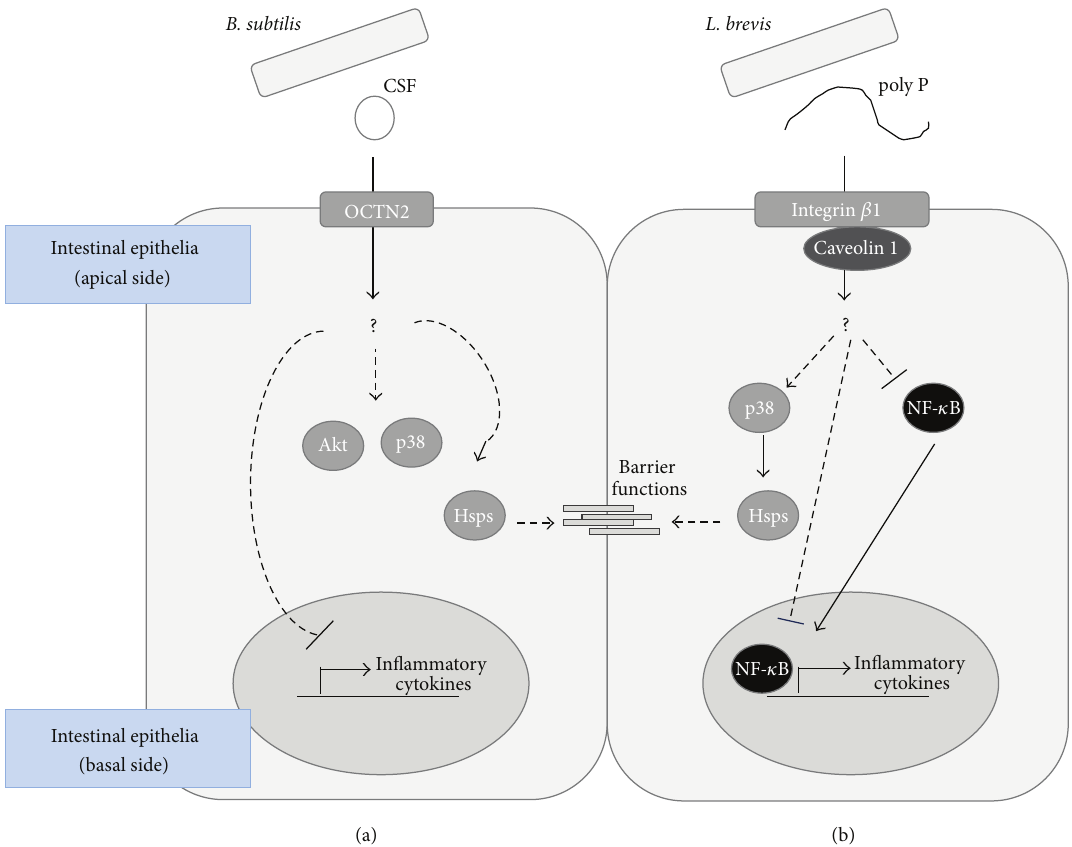
Figure 2: Bacteria-derived CSF and poly P are transported through different trafficking systems and exhibit cytoprotective and anti- inflammatory effects in human intestinal tissues. Bacillus subtilis secrets CSF, which is transported by epithelia cell membrane transporter OCTN2 (a). Lactobacillus brevis secrets poly P, which is captured by integrin 𝛽 1 and absorbed by caveolin-dependent endocytosis (b). These trafficking systems mediate the augmentation of the intestinal barrier function and exhibit anti-inflammatory